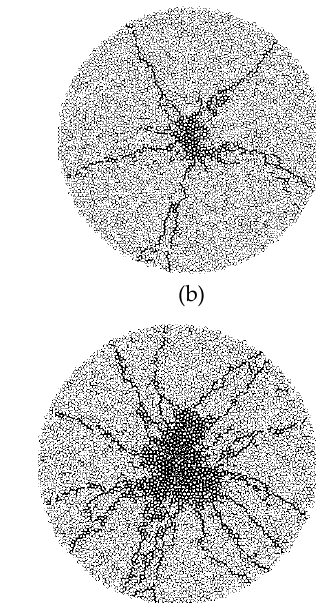
Figure 11. Surface cracking and crack propagation of EPB in granite at t = 200 μs, using different capacitances with U = 10 kV: (a) C = 0.5 μ F, (b) C = 0.8 μ F, (c) C = 5 μ F, and (d) C = 8 μ F.